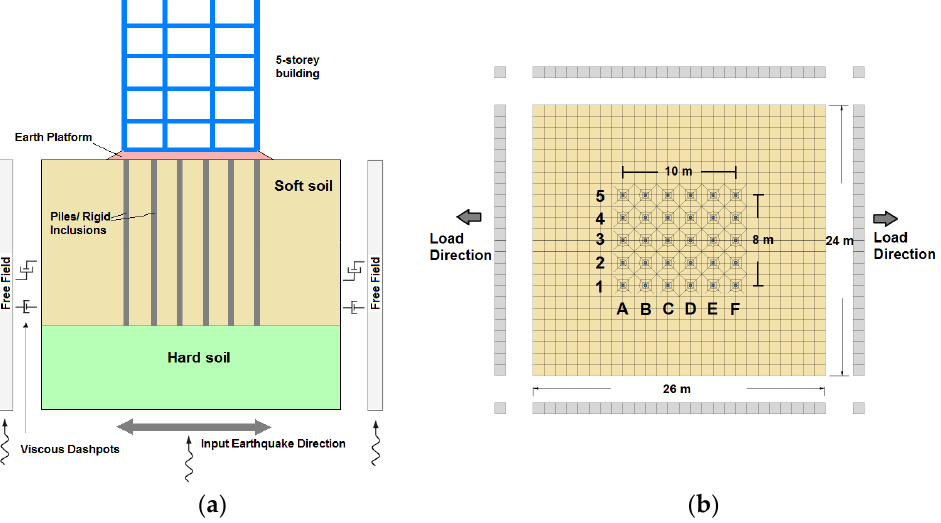
Figure 5. Schematic representation of the analyzed systems. ( a ) Cross section; ( b ) Plan view and location of the vertical reinforcements.